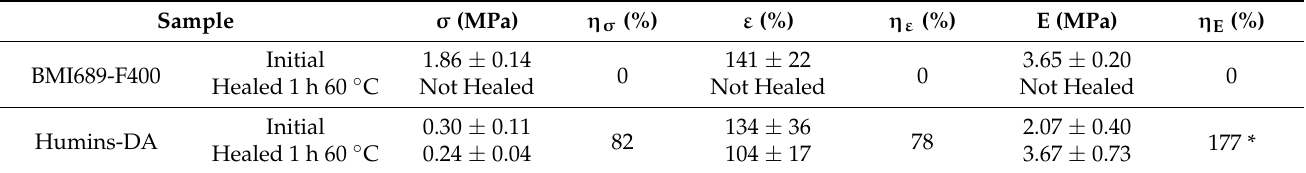
Table 2. Summary of the mechanical properties (fracture stress, fracture strain, and Young’s modulus) measured for BMI689-F400 and Humins-DA, together with their respective healing efficiencies.